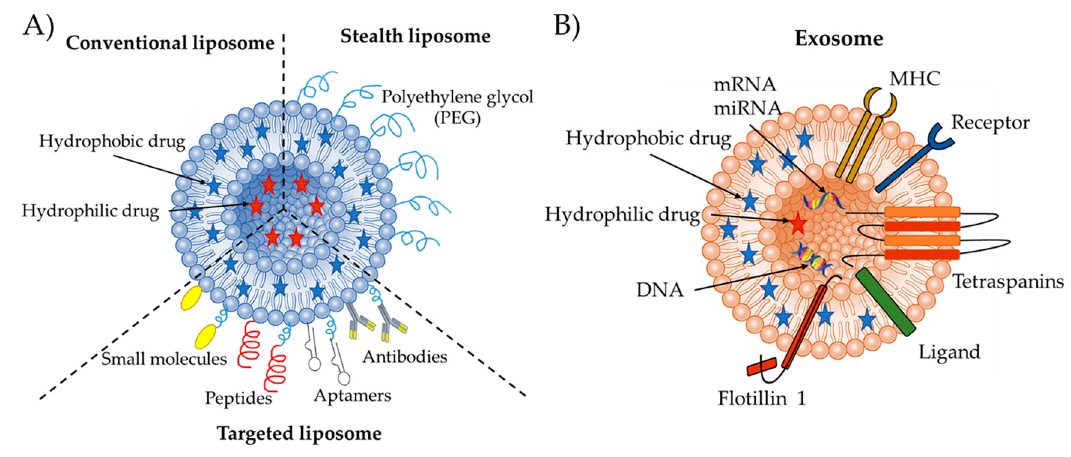
Figure 1. Schematic illustration of ( A ) conventional, PEGylated / stealth, and ligand-targeted liposome, and of ( B ) exosome structures.